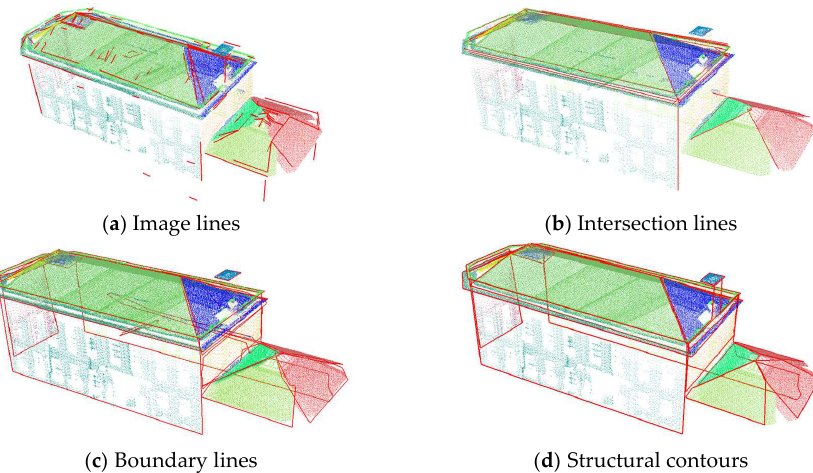
Figure 3. Visualization of the characteristics of three different feature lines and the optimized structural contours extracted from these feature lines. ( a ) Image lines: high geometric precision, non-topological, incomplete. ( b ) Intersection lines: topological support, incomplete, low correction rate. ( c ) Boundary lines: complete, poor topological support, low geometric precision. ( d ) Structural contours: optimized